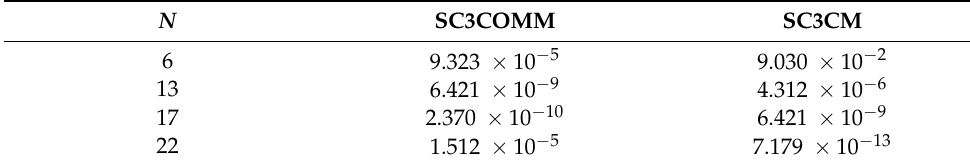
Table 5. Maximum absolute errors of Example 4.